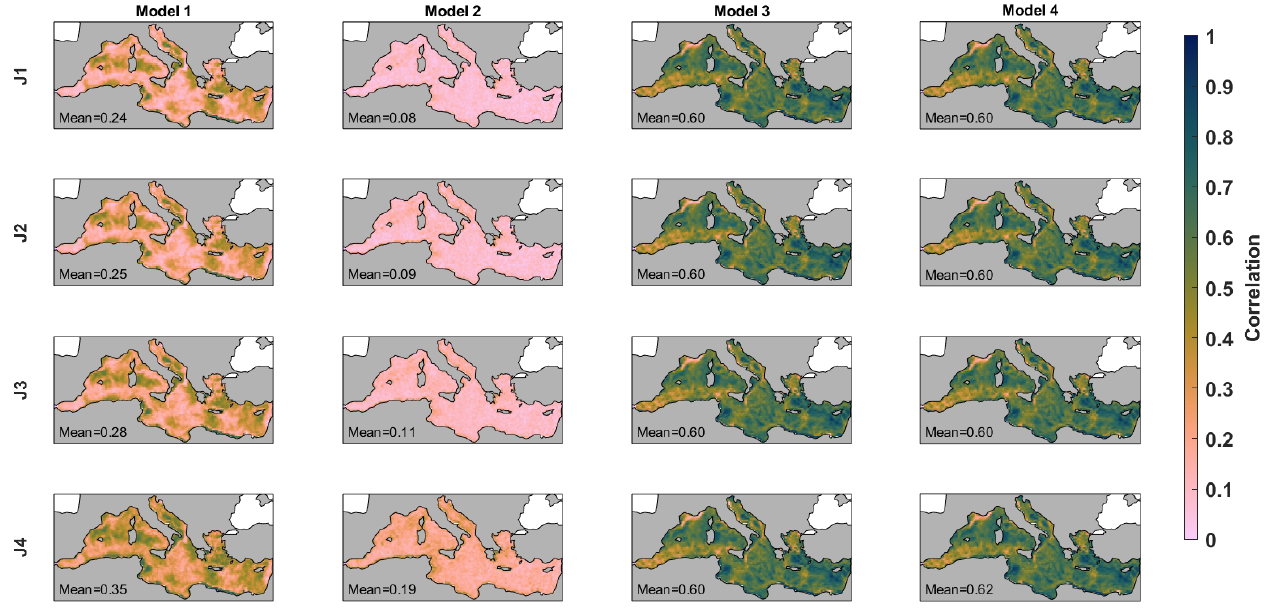
Figure 4. Temporal correlation of the forecasts using different models and cost functions with the reference dataset. Each column corre- sponds to a different forecasting model: the analogues-based forecast of the concentration (model 1), the analogues-based forecast of the concentration changes over 7d (model 2), the 7d long persistence (model 3), and the 7d long persistence in combination with the forecast of the concentration change over 7d (model 4). Each row corresponds to the different cost functions used to identify the analogues (see text for details). Note that all panels in the third column are the same, as in model 3 no cost function is used.